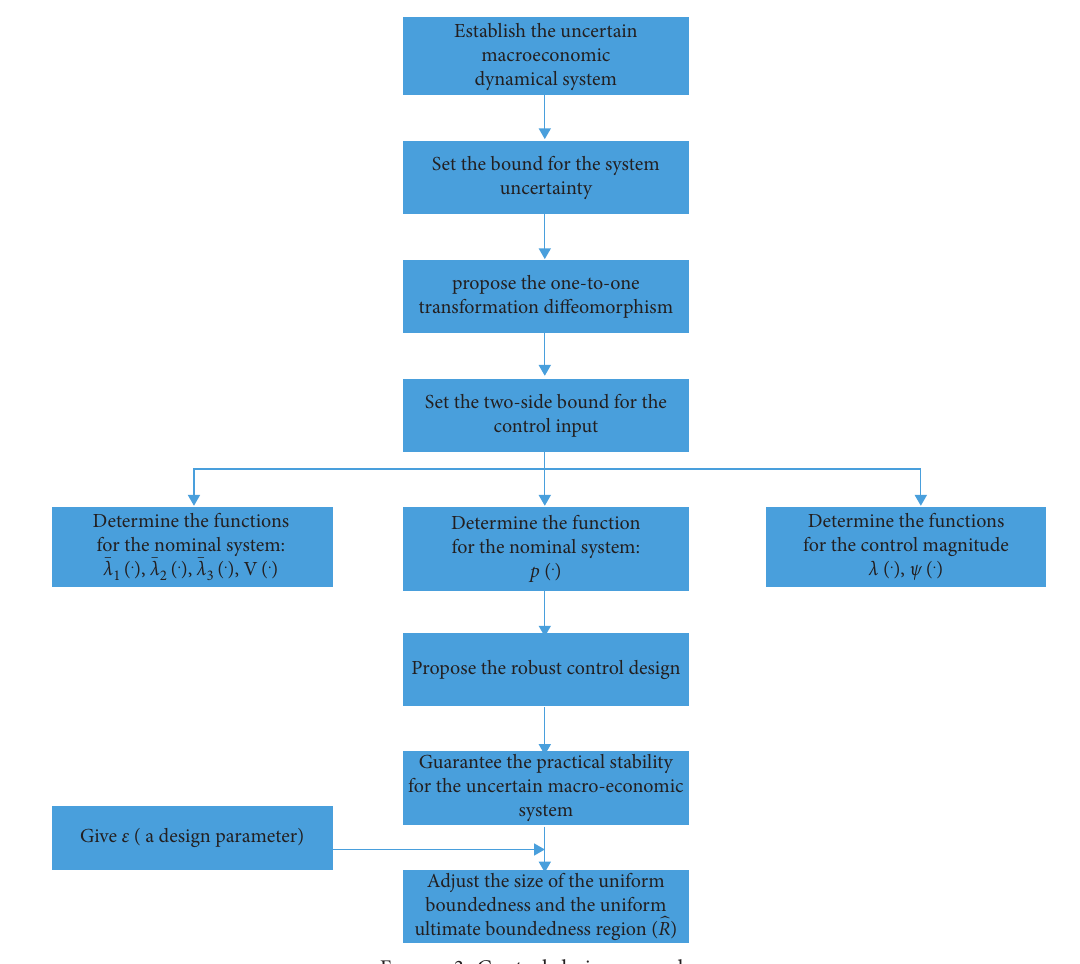
, z ) � z ∗ arctan ( z 1 2 1